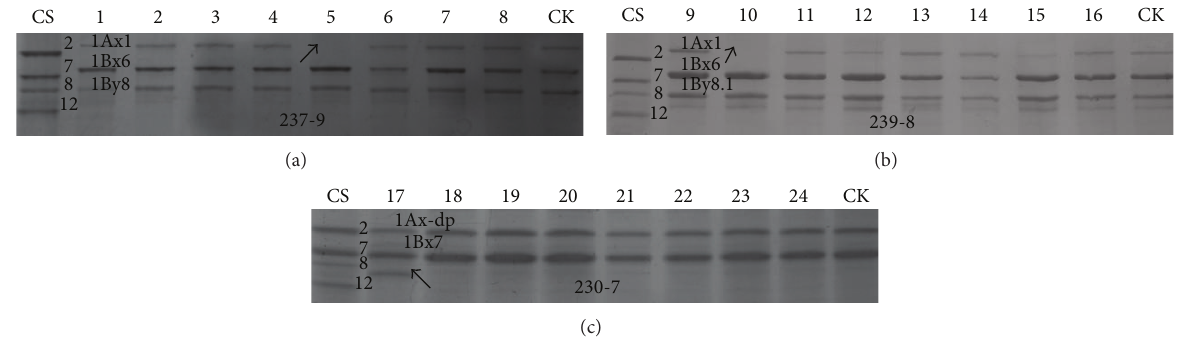
Figure 3: The SDS-PAGE of high-molecular-weight glutenins (HMW-GS). (a) CS (Chinese Spring), 1–8: seeds of plant T. dicoccoides (As835) 237-9; the absence of 1Ax1 was marked by an arrow; CK: no radiated T. dicoccoides (As835), (b) CS (Chinese Spring), 9–16: seeds of plant T. dicoccoides (As838) 239-8; the absence of 1Ax1 was marked by an arrow; CK: no radiated T. dicoccoides (As838), and (c) CS (Chinese Spring), 17–24: seeds of plant T. polonicum (As304) 230-7; the novel HMW-GS was marked by an arrow; CK: no radiated T. polonicum (As304).